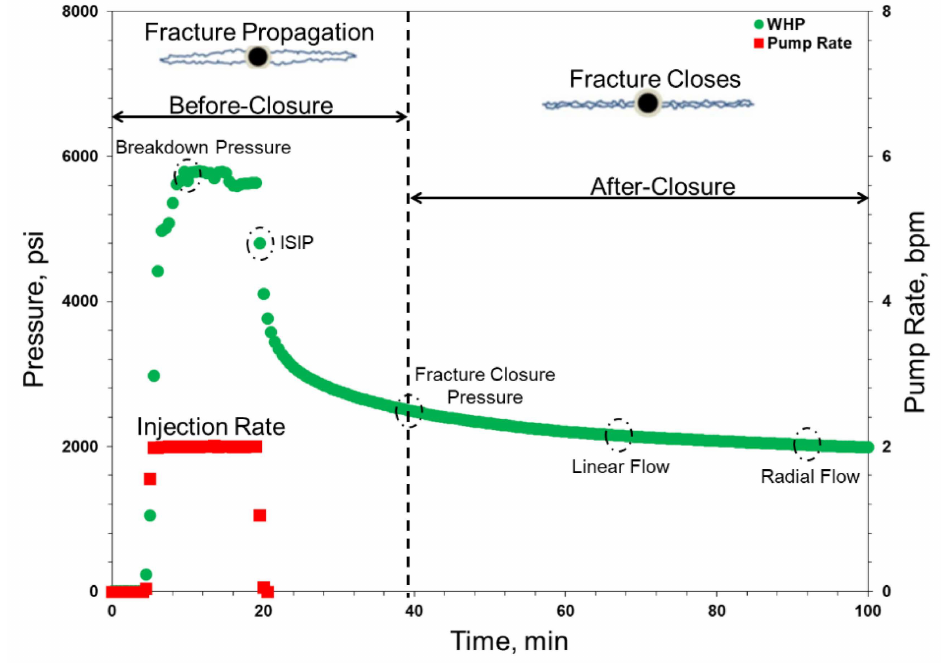
Figure 3. DFIT example of Meramec Formation includes a sequence of main events observed through pressure response before and after closure behavior (Ellafi and Jabbari,